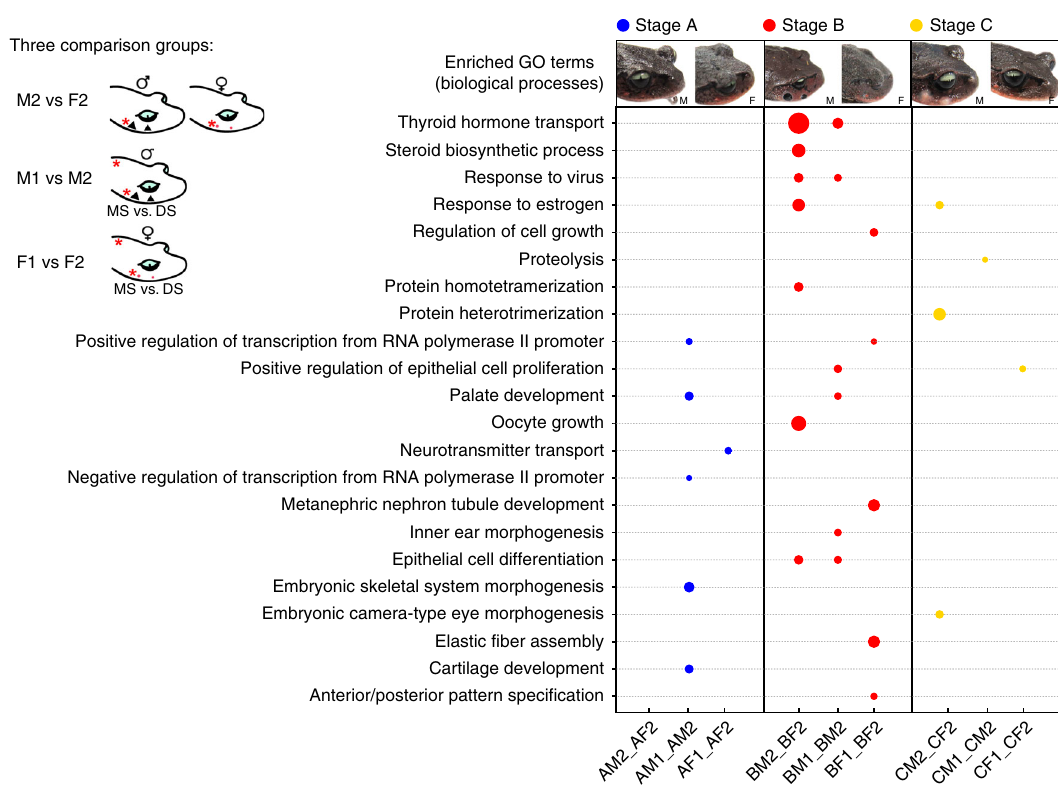
Fig. 4 Biological processes associated with producing nuptial spines in Leptobrachium leishanense . The legend in the left corner shows three groups of comparisons conducted in each stage: M2 vs F2 indicates the comparison of maxillary skin between males and females (AM2_AF2, BM2_BF2, and CM2_CF2 in the right dot plot panel); M1 vs M2 indicates the comparison of male dorsal skin and maxillary skin (AM1_AM2, BM1_BM2, CM1_CM2); F1 vs F2 indicates the comparison of female dorsal skin and maxillary skin (AF1_AF2, BF1_BF2, CF1_CF2). Red stars on the cartoon toads represent tissues used for comparison in each group. Jun Li made the hand-drawn cartoon toads in Adobe Illustrator CC 2018 with the help of Graphics Tablet (Huion, Model: H420, made in Shenzhen, China). The head fi gures on the top show the phenotypes of male (M) and female (F) L. leishanense toads at three stages. These toad photos were taken by Jun Li. The colored circles in the dot plot represent three stages, and the circle sizes represent enrichment factors with large size indicating a high degree of